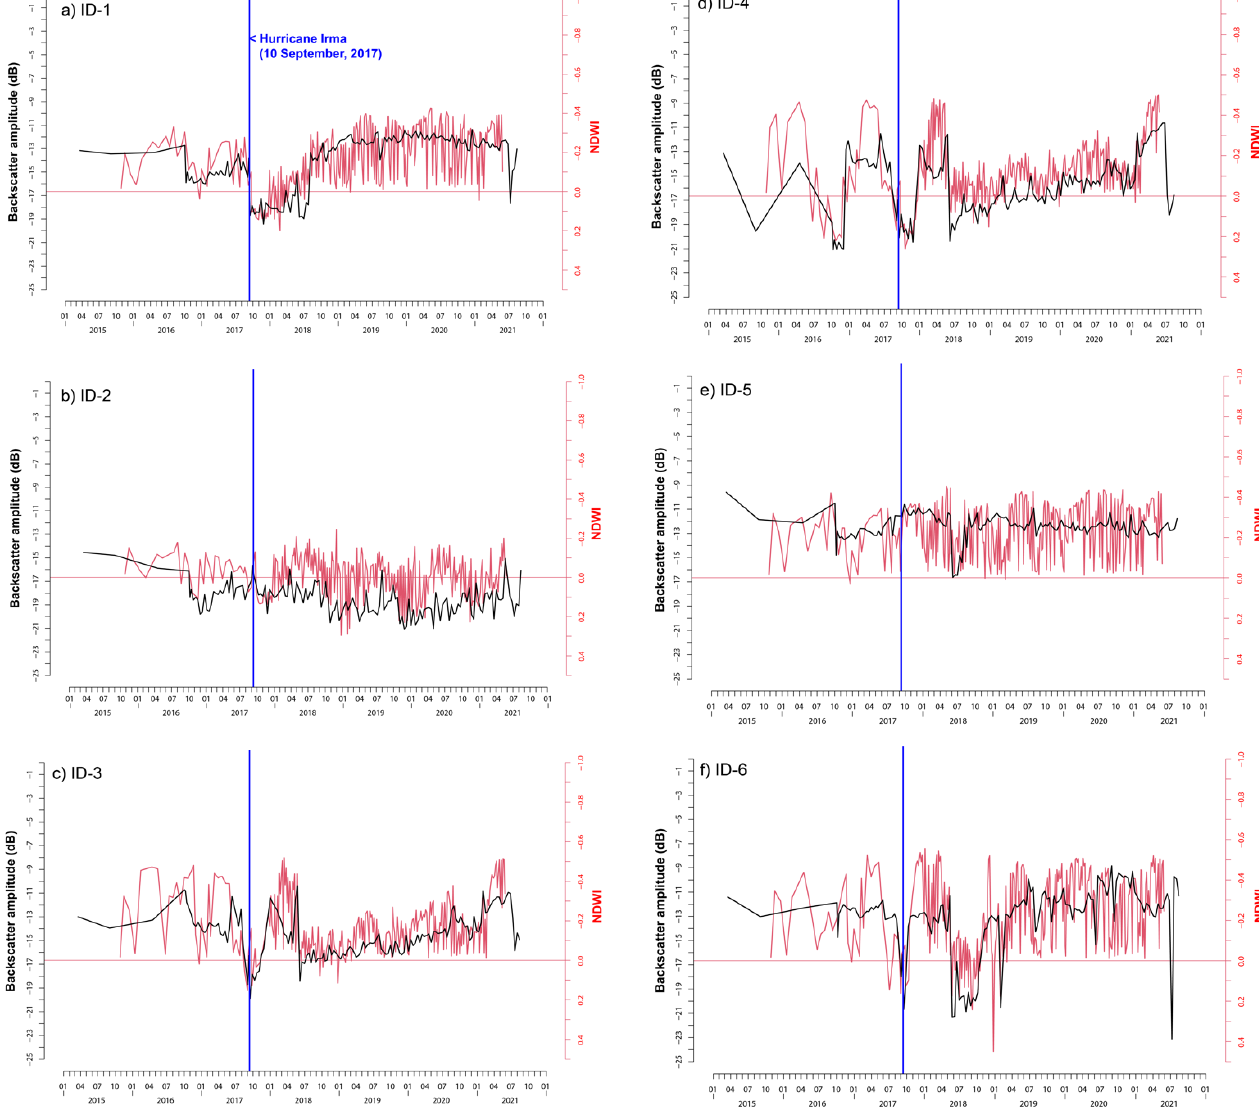
Figure 8. Temporal variations of mean values of backscatter amplitude (dB) and NDWI inside representative post-flood water bodies of ID-1-6 ( a – f ). A vertical blue line denotes the day Hurricane Irma affected the area (10 September 2017).